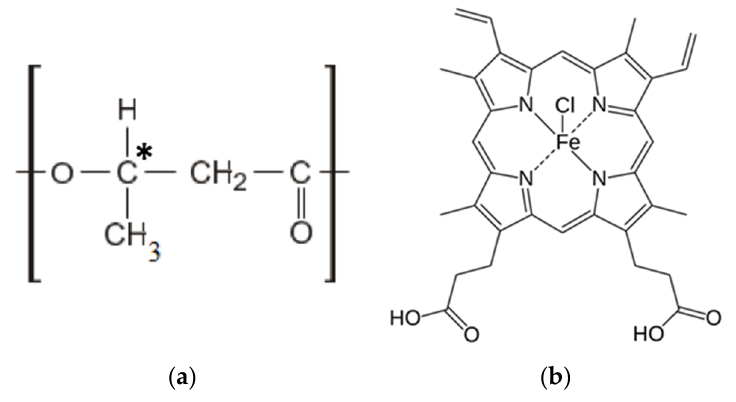
Figure 1. Structural formulas of PHB ( a ) and hemin ( b ).